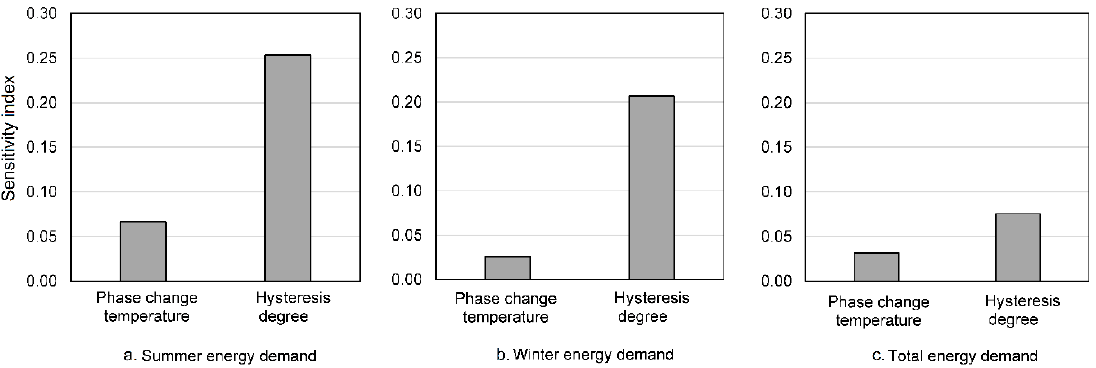
Figure 13. The sensitivity index of phase change temperature and hysteresis degree on the HVAC energy demand: ( a ) the summer energy demand; ( b ) the winter energy demand; ( c ) the yearly total energy demand.